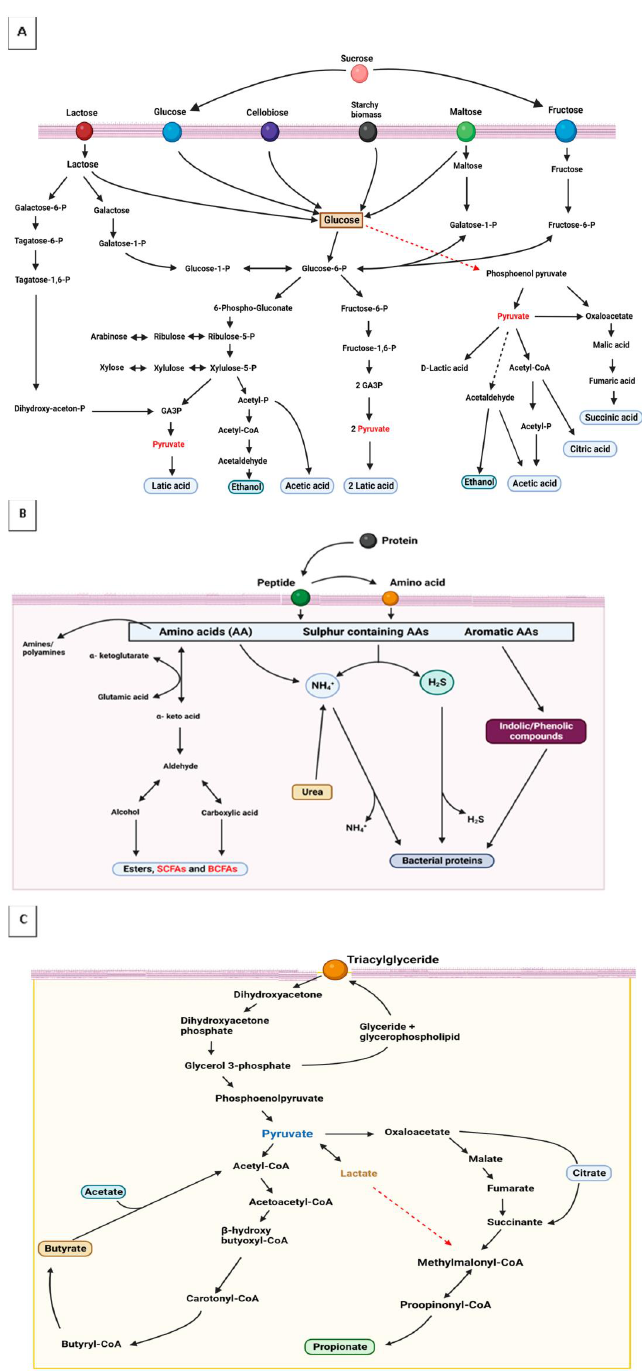
Figure 1. Macromolecules are oxidized via hydrogen ions transfers forming intermediate products that are critical modulators of hosts’ immune responses. ( A ) Carbohydrate metabolism; ( B ) protein metabolism; and ( C ) glycerol metabolism.